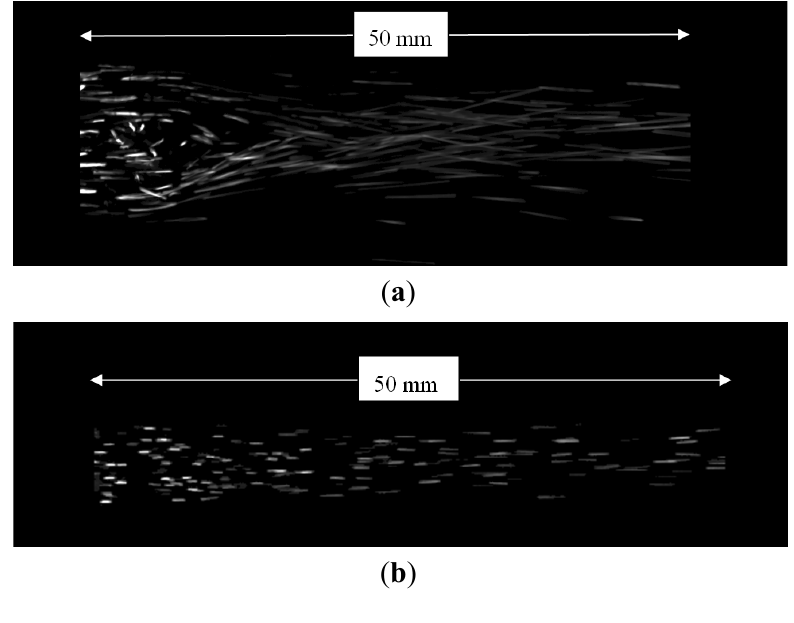
400 μ s. ( b ) Gun Head 2 (Experiment 3): From the central jet origin to 50 mm downstream. The streak brightness has been enhanced. Shutter speed: 100 μs